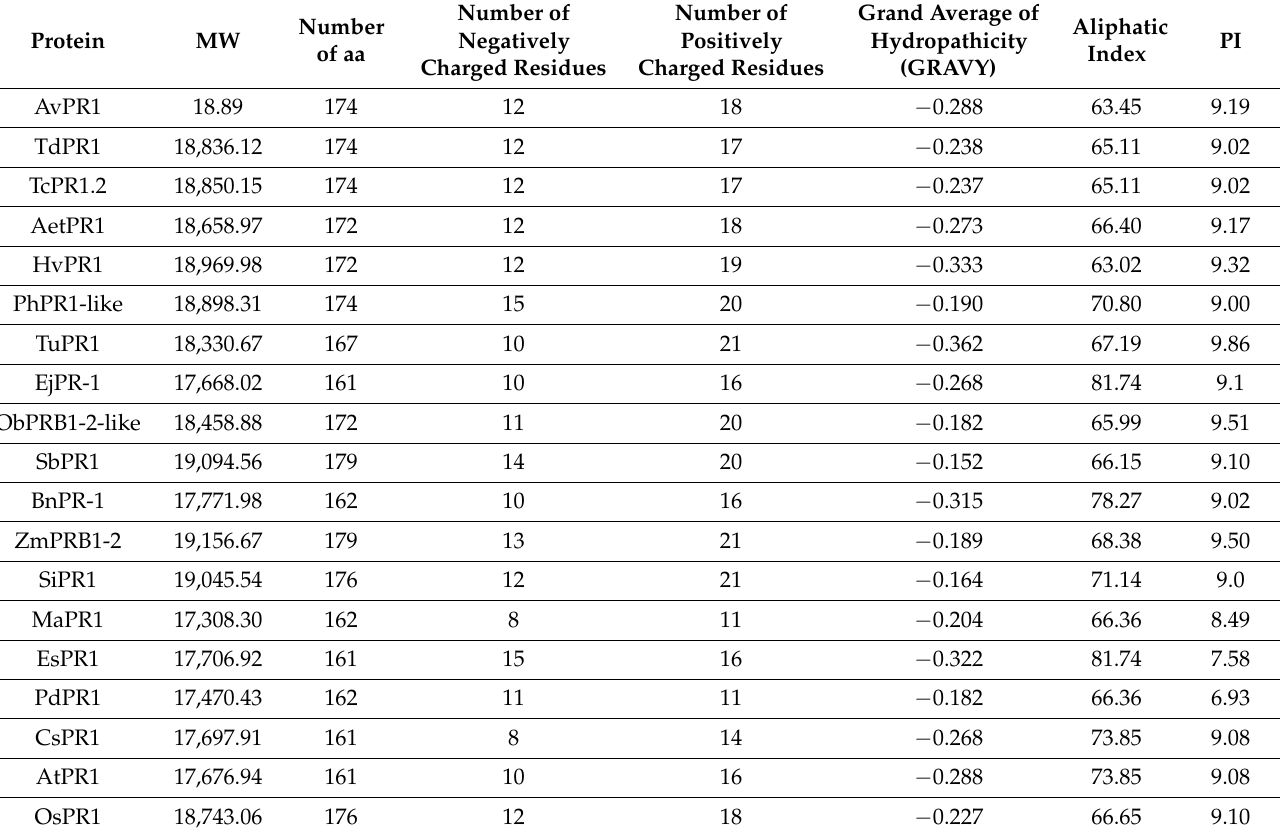
Table 1. Comparison between different isolated PR-1 from plants using ProtParam tool